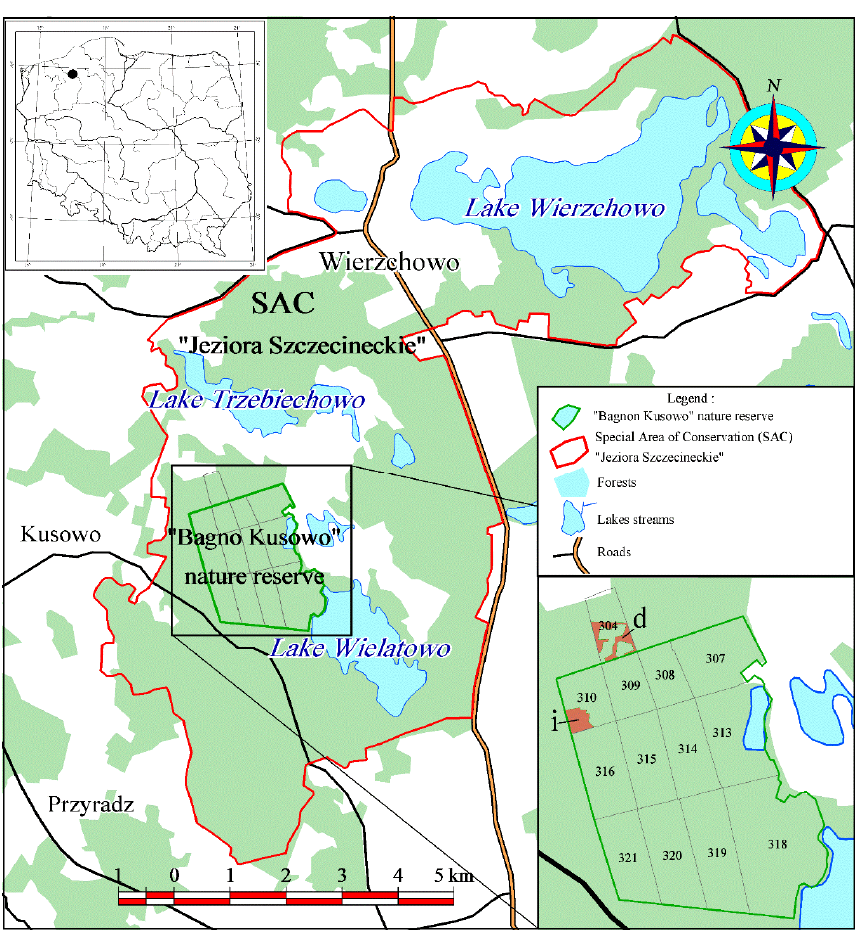
Figure 1. Location of research plots (forest sections 304d and 310i) in nature reserve “Bagno Kusowo” and Special Area of Conservation (SAC) “Jeziora Szczecineckie”.